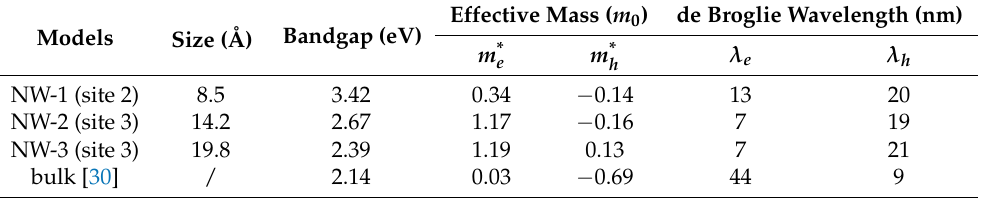
Table 2. The bandgap, effective mass values and de Broglie wavelength for Cr 2+ :ZnSe NWs and bulk. Effective Mass ( m 0 ) de Broglie Wavelength (nm) Models Size (Å) Bandgap (eV)